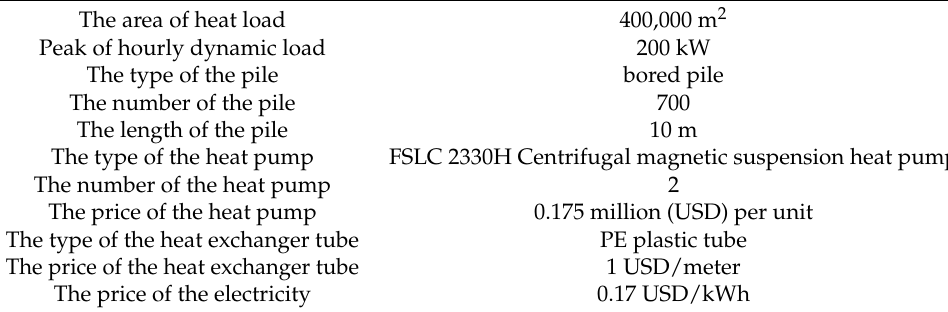
Figure 7. 3D BIM model of the prototype. Table 1. Primary design parameters of the energy pile system.